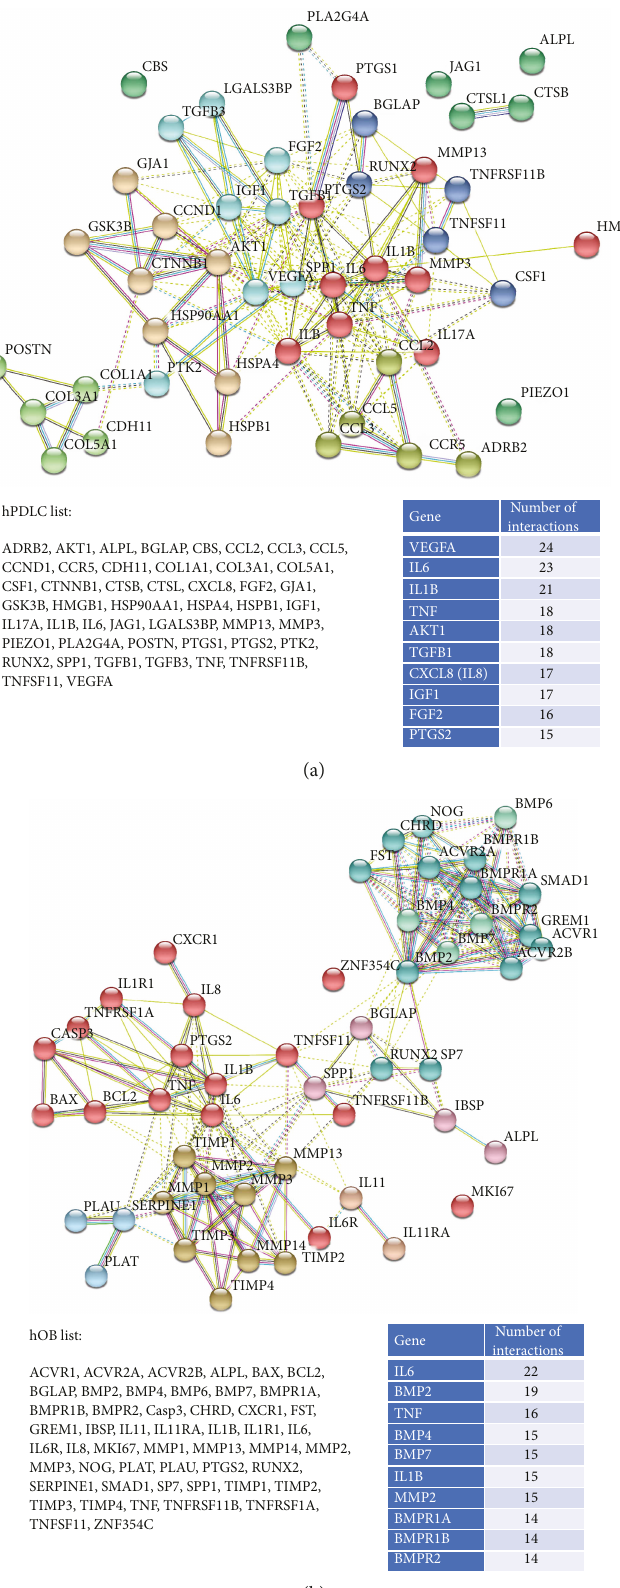
Figure 4: Protein-protein interaction networks for the (a) “ hPDLC list ” and the (b) “ hOB list ” . The gene lists are shown in the lower left part of each sub fi gure. Those genes with the highest number of interactions ( “ top 10 ” ) are given in tables in the lower right part of each sub fi